Question: Give a one-sentence summary of this figure.
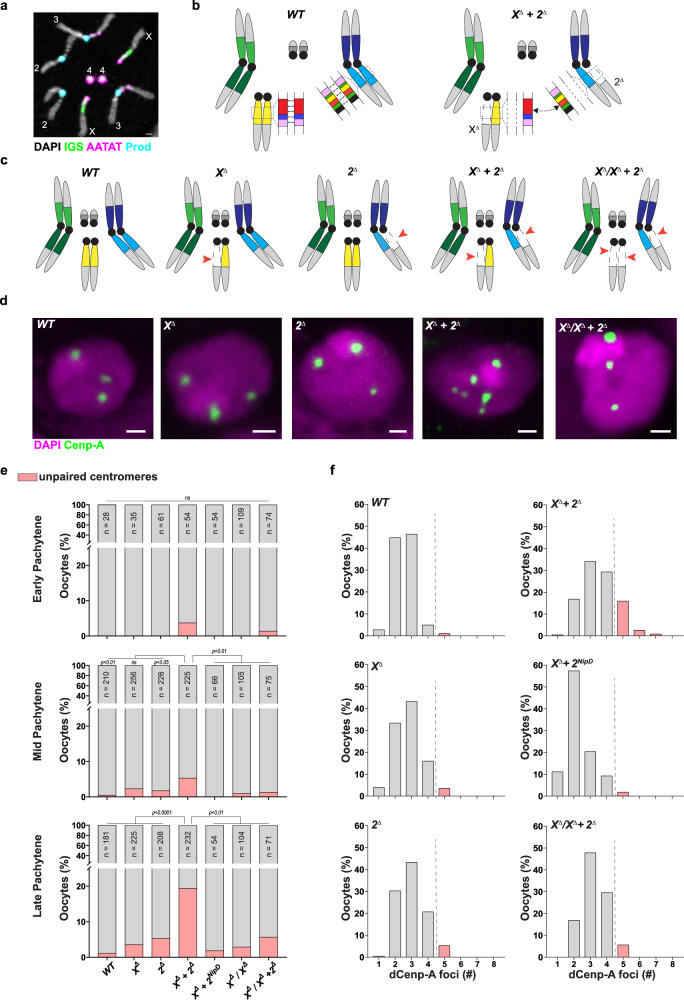
Answer: Pericentromeric satellite DNA repeats function in meiotic centromere pairing. a DNA FISH against the IGS satellite repeat (green), the (AATAT) n satellite repeat (magenta) and the Prod /(AATAACATAG) n satellite repeat (cyan), co-stained with DAPI (white) on mitotic chromosomes from WT Drosophila . b Schematic of the Drosophila karyotype with chromosome-specific satellite DNA arrays or satellite DNA ‘barcodes’. Each satellite DNA barcode is made up of individual repeats (red, blue, light pink etc), shown here for two chromosomes, which are capable of self-association. These individual repeats may mediate non-homologous associations (dashed arrow, right panel) when the satellite DNA barcodes are mismatched. c Schematic of the genotypes used in this figure. Red arrows indicate satellite DNA deletions. d IF against dCenp-A (green) in late pachytene oocytes co-stained with DAPI (magenta). e Quantification of oocytes with >4 dCenp-A foci, indicating unpaired centromeres, in early, mid and late pachytene in the indicated genotypes. n indicates the number of oocytes analysed, and p- values were obtained from a two-sided Fisher’s exact test. ns indicates p > 0.05. f Histogram showing the distribution of the number of dCenp-A foci from ( e ). All scale bars are 1 µm. Source data are provided as a Source Data file. p- values of individual comparisons can be found in Supplementary Data 1 .